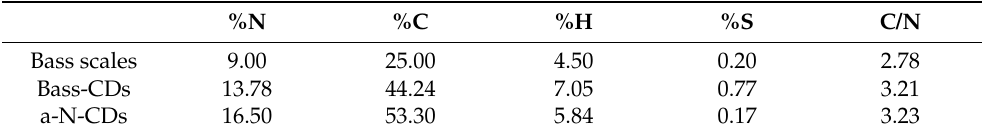
Table 1. Elemental percentage composition of bass scales, bass-CDs and amorphous nitrogen-doped carbon dots